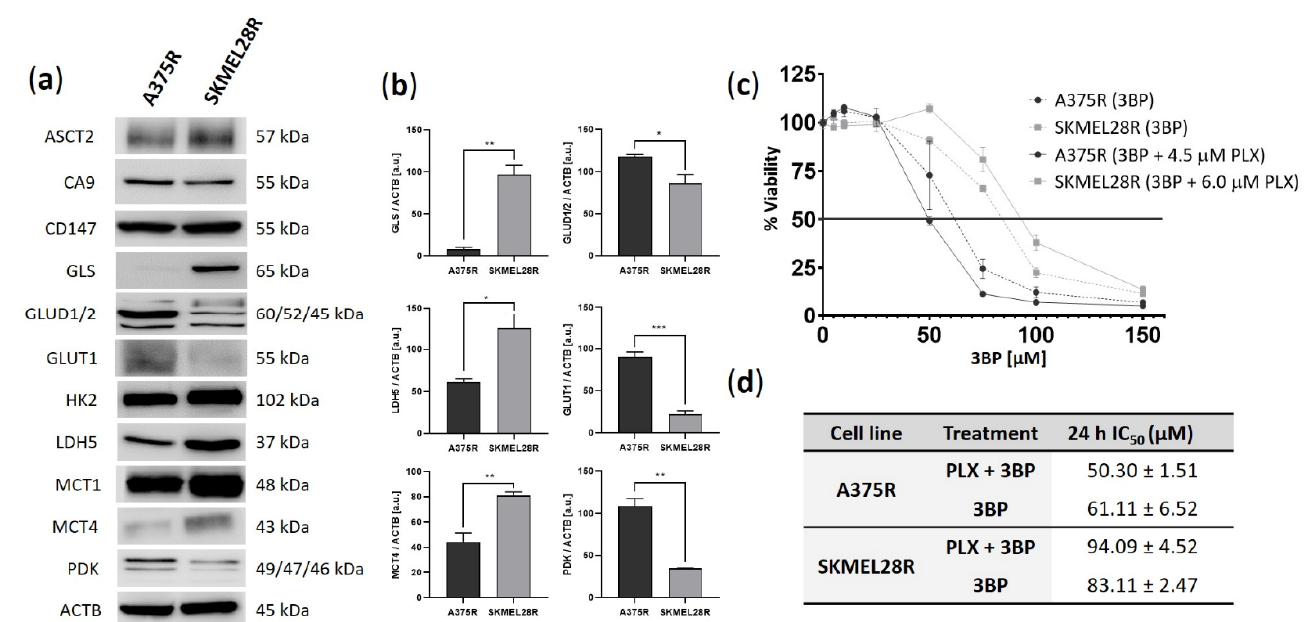
Figure 1. Basal expression of metabolic proteins and cell viability analysis using a sulforhodamine B (SRB) assay in vemurafenib (PLX)-resistant melanoma cells treated with 3-bromopyruvate (3BP) for 24 h. ( a ) Western blot analysis of the basal levels of ASCT2, CA9, CD147, GLS, GLUD1/2, GLUT1, HK2, LDH5, MCT1, MCT4, and PDK in PLX-resistant melanoma cells. ( b ) Quantification of immunoblots normalized to ACTB levels. The y -axis represents arbitrary units [a.u.]. Data represent the mean ± SEM of at least three independent experiments. ( c ) The dose–response curve represents the viability of PLX-resistant melanoma cells treated with 0–150 µM 3BP, either alone or combined with PLX (4.5 µM for A375R cells and 6.0 µM for SKMEL28R cells). Data were normalized to the vehicle control (100%). ( d ) IC 50 values of PLX-resistant melanoma cells treated with 3BP for 24 h. Data represent the mean ± SEM of at least three independent experiments performed in triplicate. *